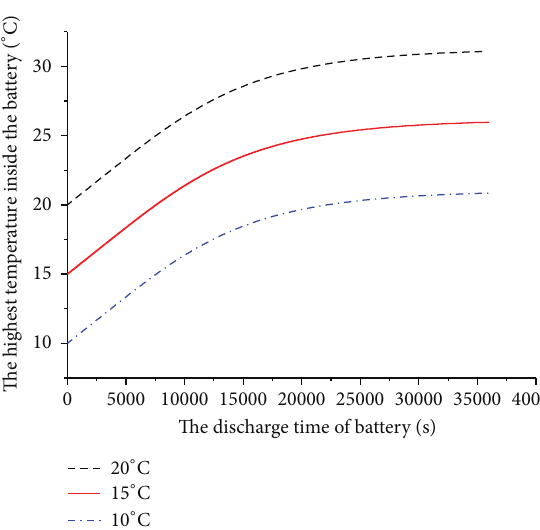
Figure 15: The battery compartment maximum temperatures over time when the speed is 6